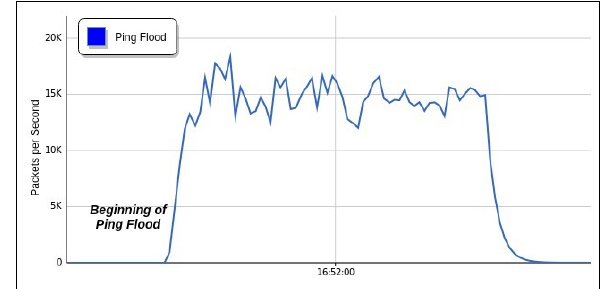
Figure 5. Unprotected DoS Flow